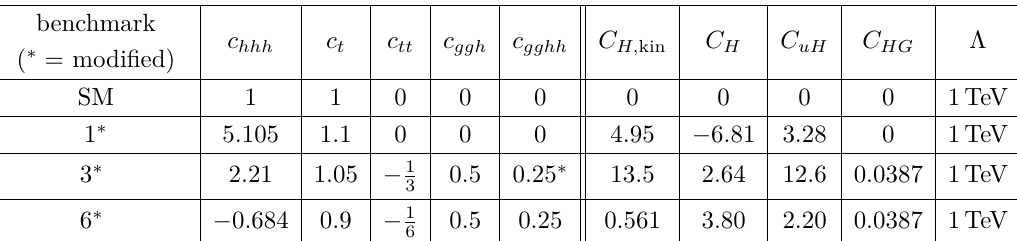
is determined using HG